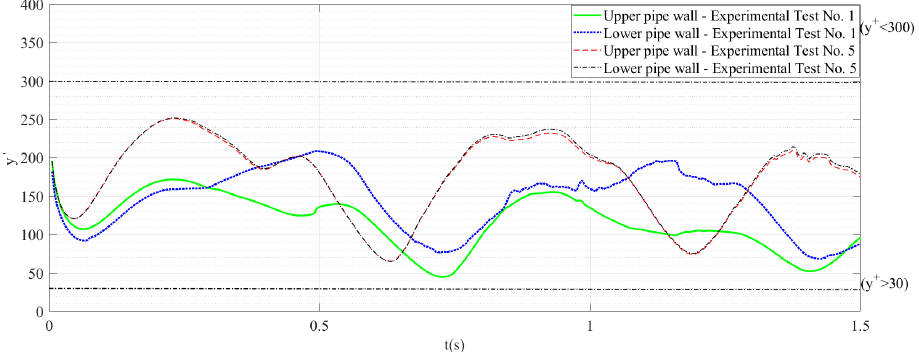
Figure 7. y + on the computational